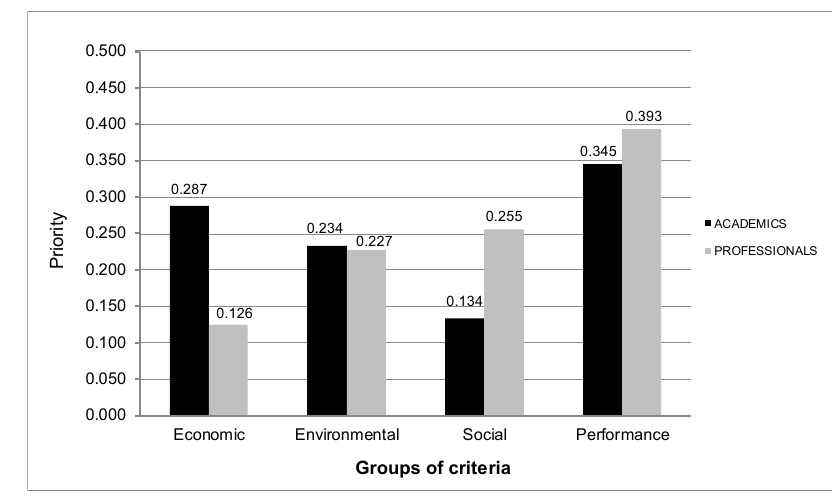
Figure 3. Priorities assigned to groups of criteria by Academics and Professionals.